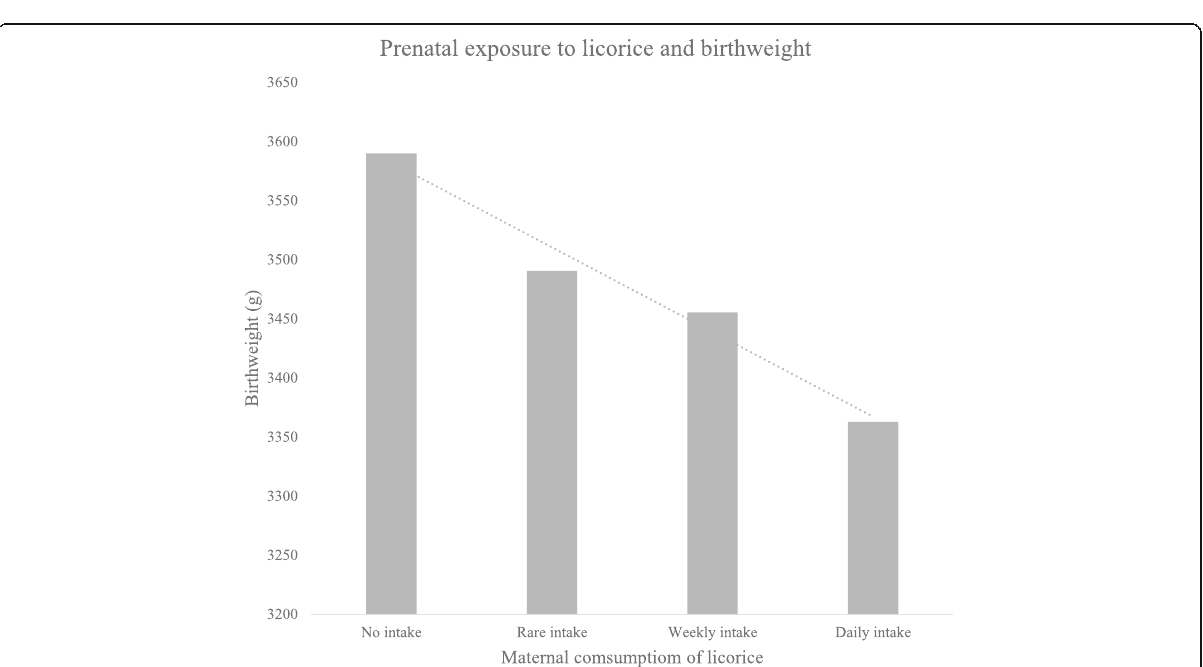
Fig. 1 Association between birthweight and prenatal exposure to maternal licorice consumption. Maternal consumption of licorice showed an association with a reduced birthweight. Mean birthweight 3590 g, 95% CI: 3327-3853 g in the group with no intake A , mean birthweight 3490 g, 95% CI: 3392-3589g ( p = 0.62) in the group with a rare intake, mean birthweight 3455 g, 95% CI: 3335-3575g ( p =0.35) in the group with a weekly intake vs. mean birthweight 3363g, 95% CI: 3010-3716g ( p =0.29) in the group with a daily intake. A Reference group